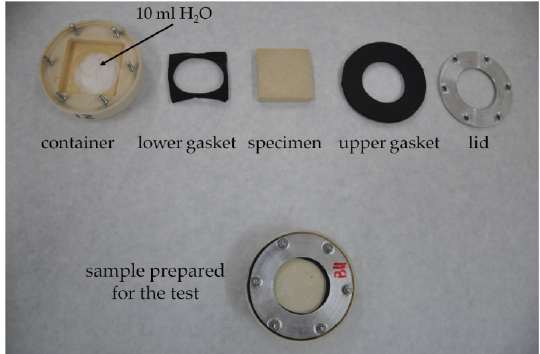
Figure 1. Set ‐ up for water vapour permeability test. Figure 1. Set-up for water vapour permeability